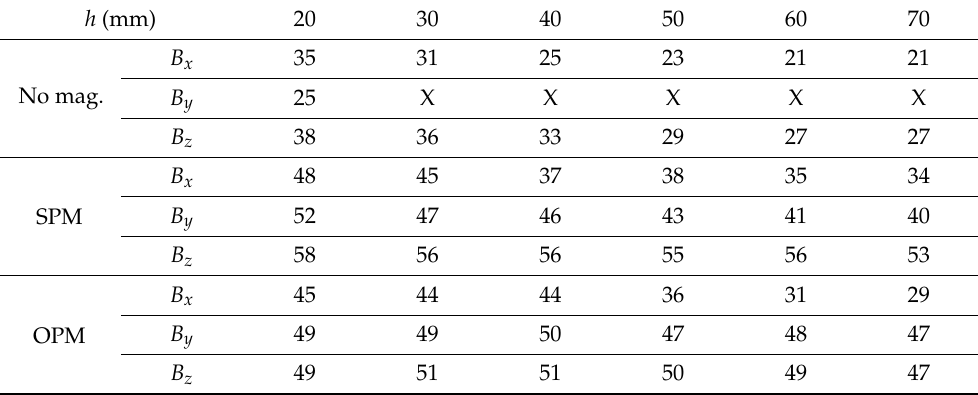
Table 2. Signal noise ratio SNR (dB) calculated for measurements obtained using AMR sensor for different concrete cover thicknesses h , and different magnetization